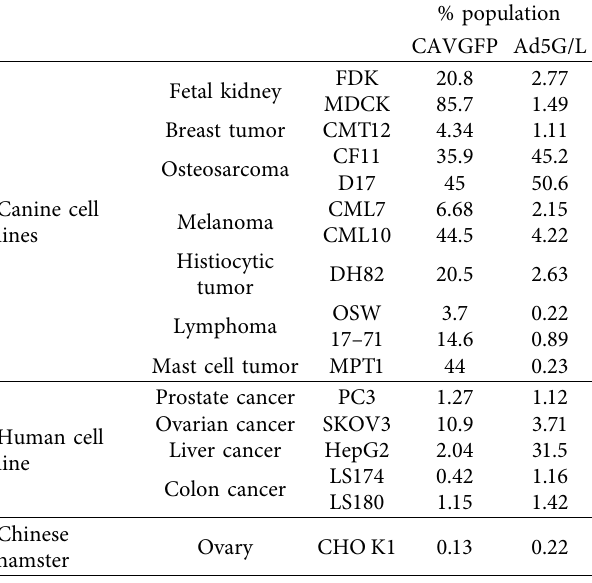
Table 1: Percentage of population infected by CAVGFP and Ad5G/L in canine and human cell lines. Cells were transduced by adenovirus CAVGFP and Ad5G/L at 100 multiplicity of in- fection (MOI 100 virus particles per cell). Percentage of population expressing GFP was analyzed by fow cytometry 48 hours after infection. Te results presented here are the average of three in- dependent infection